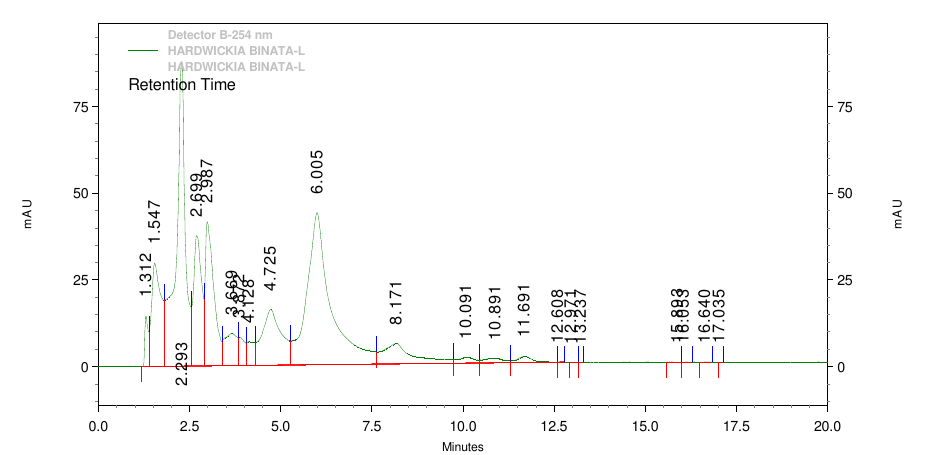
Figure 3 . HPLC finger print profile of ethanolic extract of Hardwickia binata